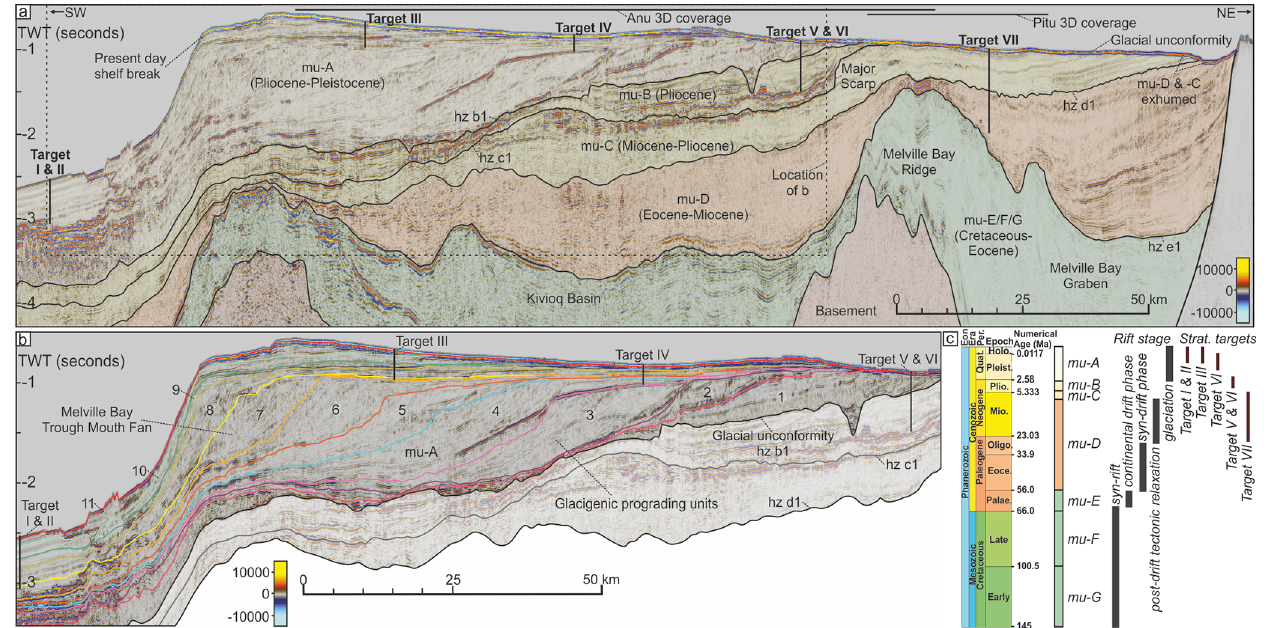
Figure 2. Regional geology. (a) A 2D regional seismic reflection line showing the stratigraphy and structure across the shelf. Regionally mapped seismic mega-unit interpretations from Gregersen et al. (2013, 2017) and Knutz et al. (2015) are shown as well as the projected locations of the seven IODP Proposal 909 stratigraphic targets and the comparative coverage of 3D seismic data. (b) An enlarged section of the seismic line from A that focusses on the glacigenic wedge that represents the Melville Bay Trough Mouth Fan system, showing the 11 interpreted sub-units of mega-unit (mu)-A from Knutz et al. (2019) as well as the projected location and depth of the IODP Proposal 909 sites. The location of the seismic line is shown in Fig. 1. (c) A stratigraphic column displaying seven seismic mega-units and their associated rift stages, as well as the expected age of the stratigraphy that comprises each of the stratigraphic targets